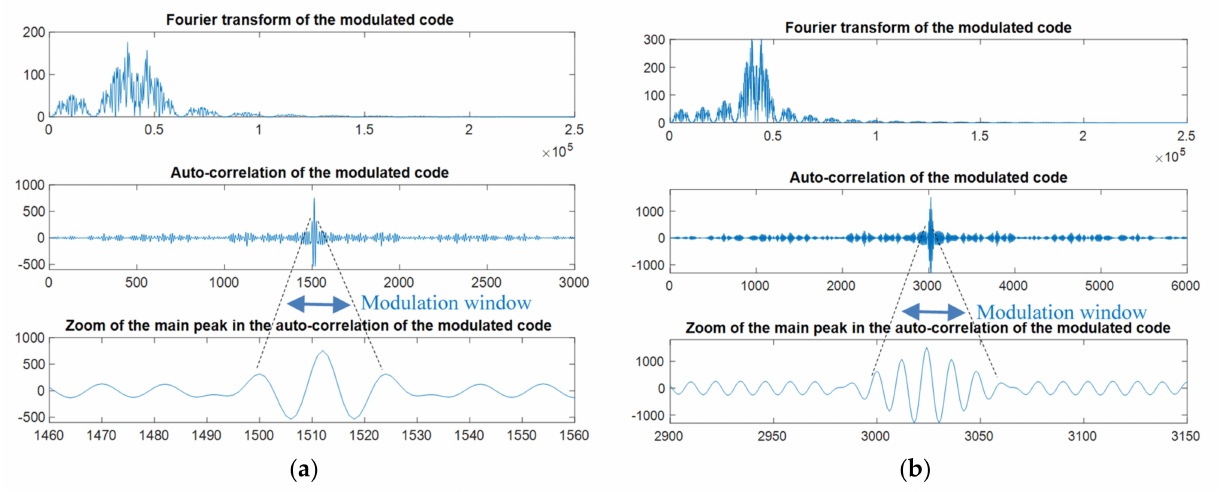
Figure 4. Effect of the BPSK modulation in the auto-correlation function of a 63-bit long Kasami code with f c = 41.67 kHz, f s = 12 and: ( a ) O c = 2; ( b ) O c =